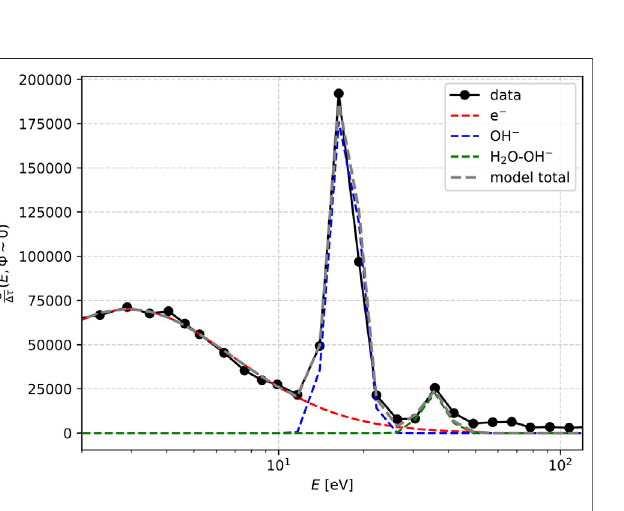
FIGURE 7 | Observations of CAPS Electron Spectrometer during the Enceladus encounter on 12-03-2008. The arrows indicate signatures of electrons, OH − and H 2 O-OH − ions. The magenta square shows a time period in which both OH − and H 2 O-OH − ions are detected within the energy-per-charge range of the instrument.